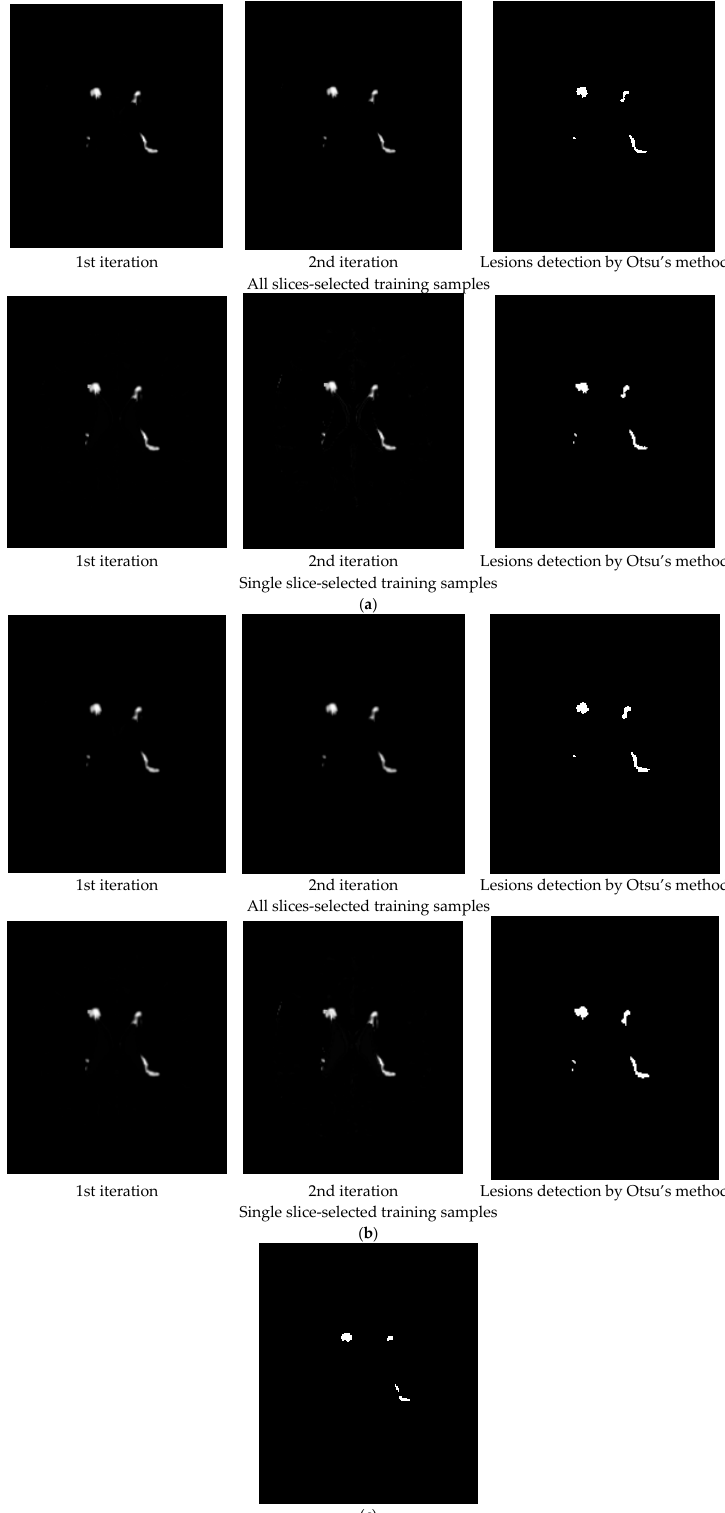
Figure 5. Lesion detection of Slice 97 with 0% noise and 0% INU by CBEP-ICEM1 and